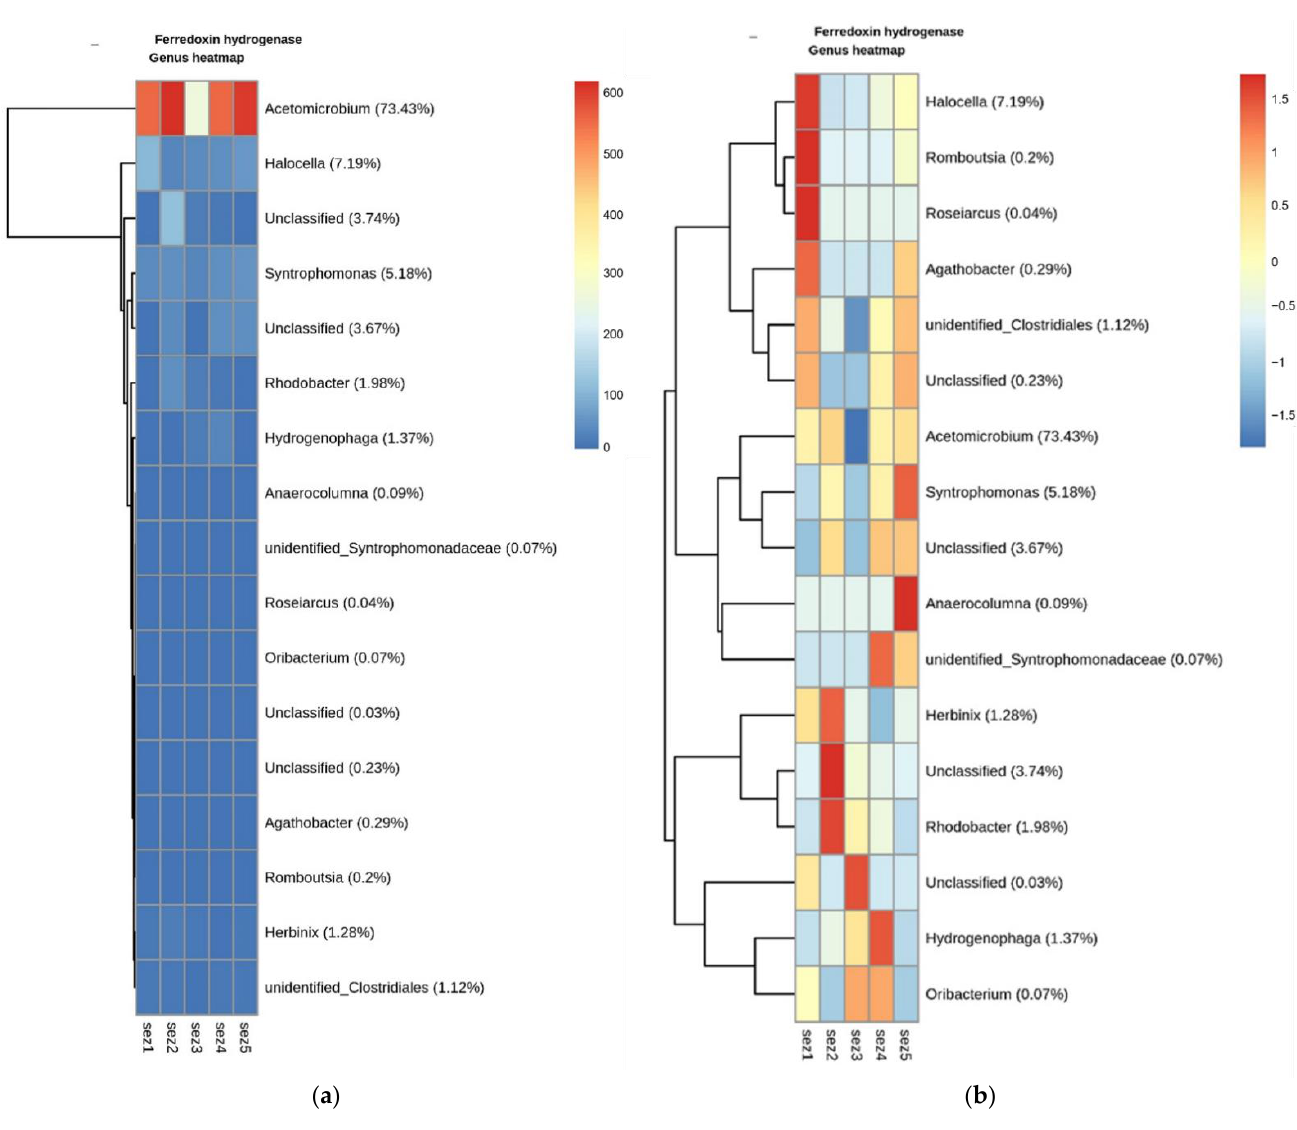
Figure A8. Functional heatmaps of ferredoxin hydrogenase: ( a ) absolute counts and ( b ) autoscaled counts, aggregated at the genus level.